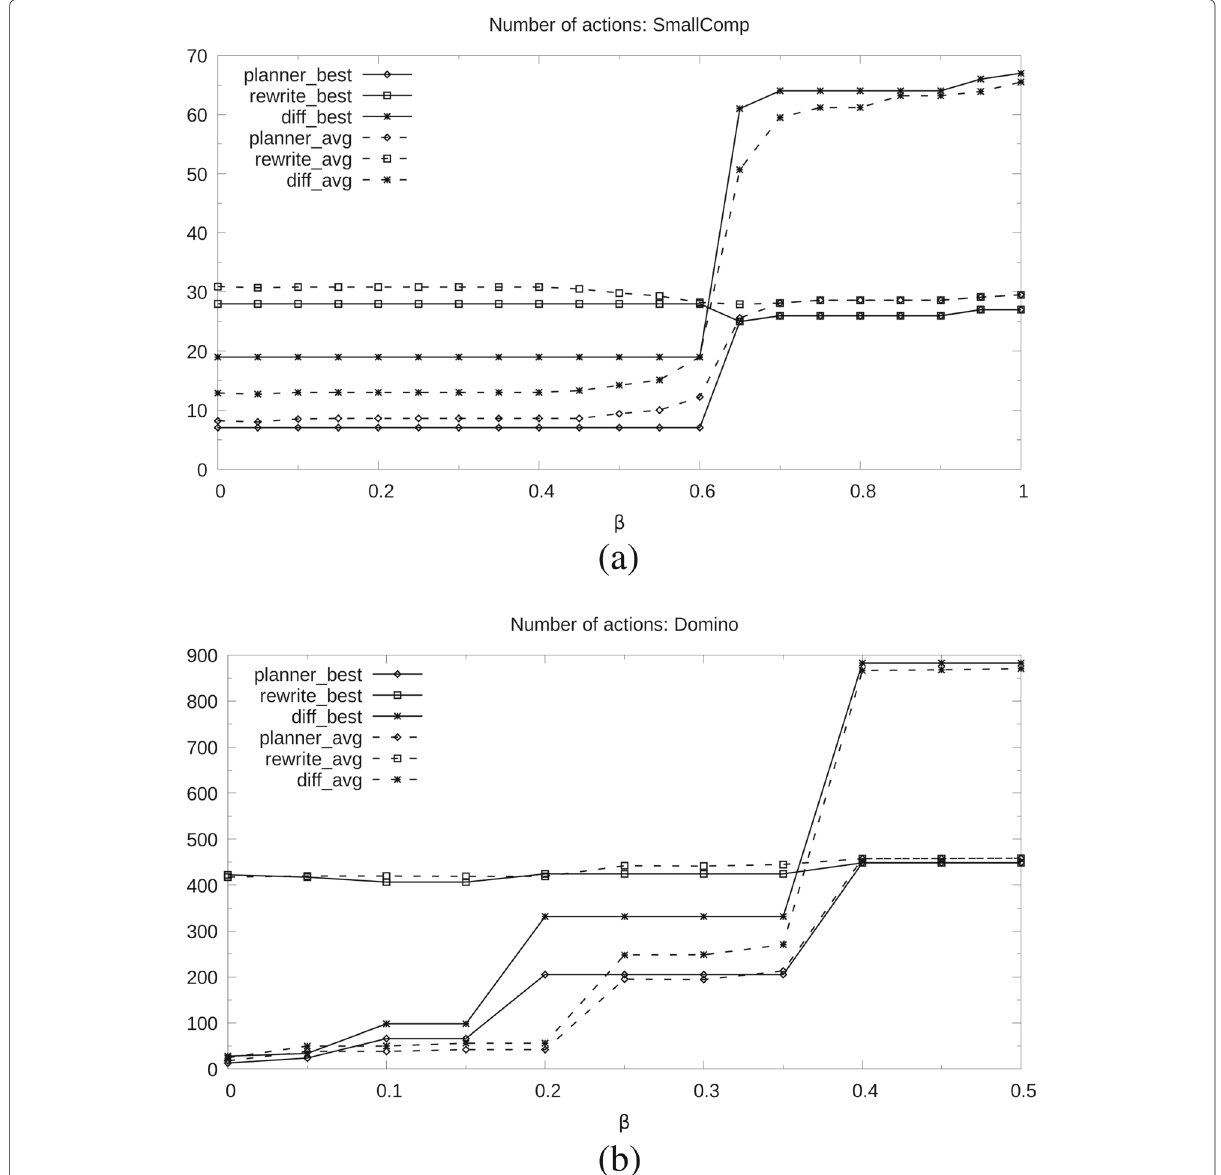
Fig. 10 As shown in Fig. 10 (a) ( SmallComp ) , our planner ouperforms on average both baselines: It is able to create a plan which is shorter than the difference between matrices ( diff ) and shorter than the list of actions necessary to rebuild the target RBAC state from scratch ( rewrite ). On average, with β ≤ 0.65 we have an